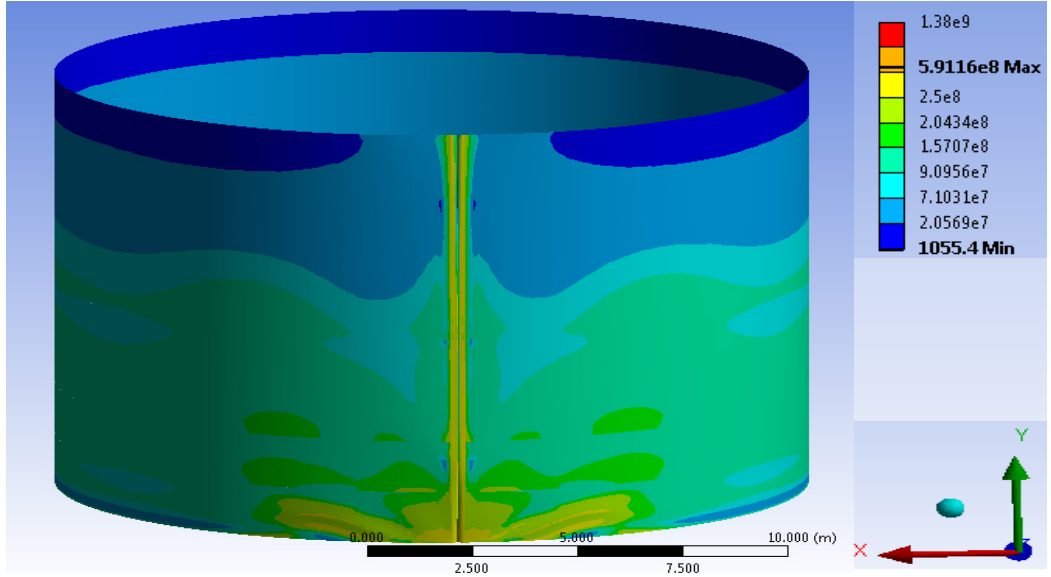
Figure 18. Distribution of equivalent stresses in the field joint zone with the joint imperfection at a = 15 cm; f = 10 cm.